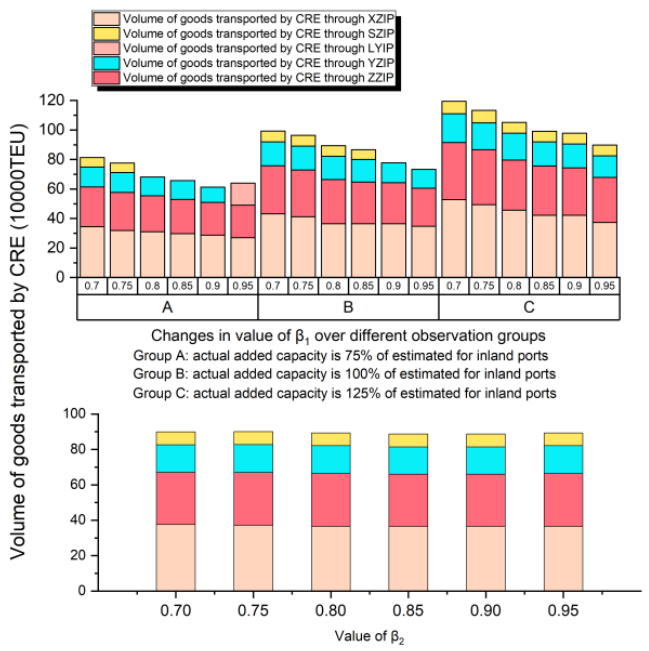
Figure 11. Changes in volume of goods transported by CRE when β1, β2, and capacity of inland ports changes.